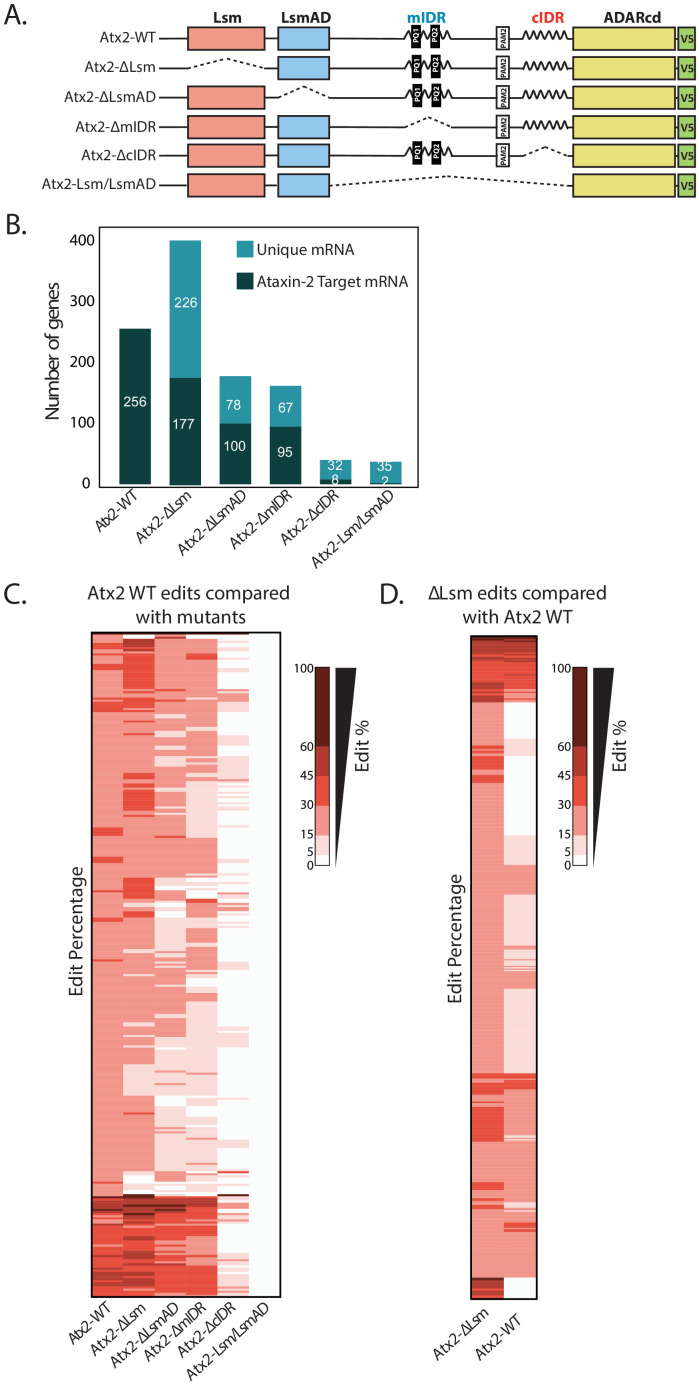
Atx2 requires its cIDR domain for interaction with its target mRNA.(A) An illustration of domains of Atx2. The structured (Like-Sm [Lsm] and Lsm-associated [LsmAD]) and disordered domains (mIDR and cIDR) of Atx2 protein were deleted one at a time to understand the domains necessary for its interaction with target RNA. The wild-type Atx2 and the deletions contained a c-terminal ADARcd and V5 tag. The deletions are shown by the dotted lines. (B) Deletion of LsmAD or mIDR domain reduced the ability of Atx2 to interact with its targets, while cIDR deletion almost entirely prevented Atx2 mRNA interactions. The Lsm-domain deletion showed an overall increase in mRNA edits. (C) More detailed heatmap view of individual target mRNAs showing target edit percentages in flies expressing control or domain-deleted forms Atx2 fused to ADARcd. (D) Most of the apparently new targets identified in Atx2∆Lsm Targets of RNA-Binding Proteins Identified by Editing analyses are also edited, albeit at a lower efficiency, in flies expressing full-length Atx2-ADAR fusions. This suggests that deletion of the Lsm domain increases the interaction of Atx2 with its native target mRNAs. (For C and D, 15% threshold edits identified for samples in column 1 [Atx2 WT in C and Atx2∆Lsm in D] was used to compare with all the edits of the rest of the columns to generate a heatmap.)
Figure 4—source data 1.Data related to Figure 4B.mRNA targets identified for different Atx2 domain deletions.

Figure 4—source data 2.Data related to Figure 4C, D.Edit percentages for Atx2-target mRNAs identified using different domain deletions.